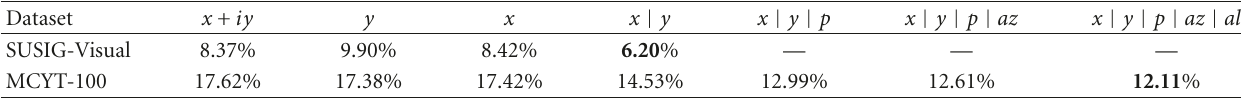
Table 2: Equal error rates obtained using di ff erent components of the input signal. The timestamp is discarded after incorporating the pen-up durations into the trajectory, for the SUSIG